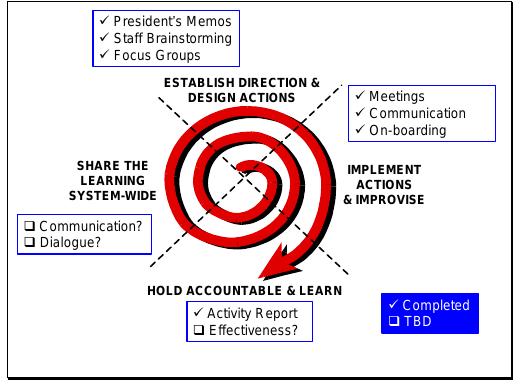
Figure 4 : Guided Changing at